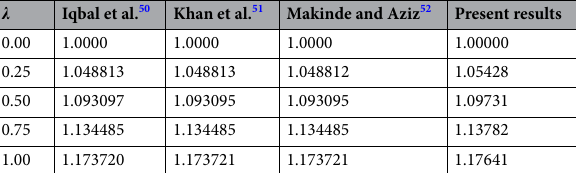
0 ) with previously reported results, when (cid:31) f ′′ (ξ = −